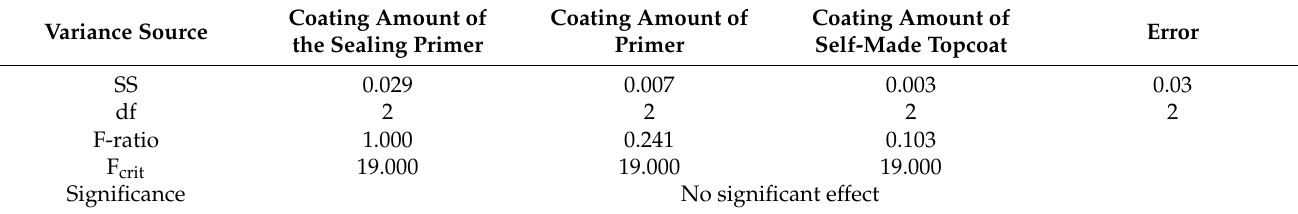
Table 4. Variance analysis of the weight loss of the